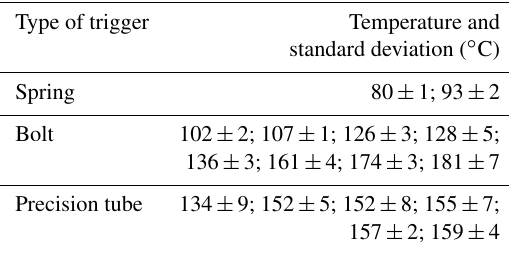
Table 1. Average temperature and standard deviation at which an SMA trigger was activated. Data from three trigger mechanisms and multiple discrete SMAs are listed for combinations that were tested more than three